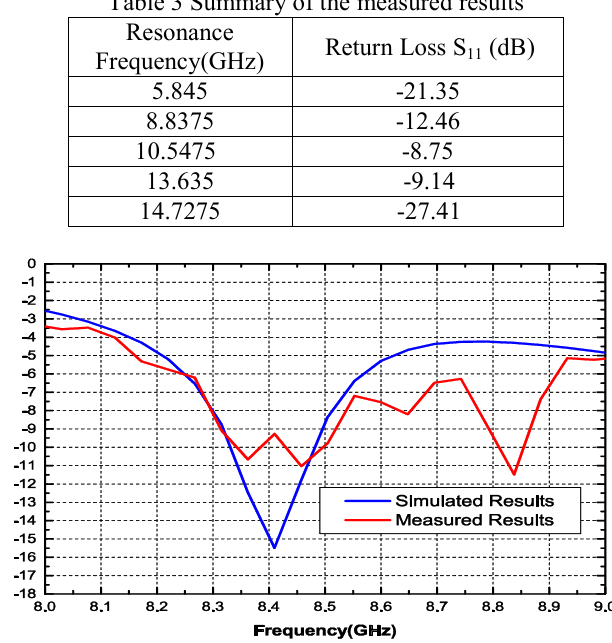
Figure 15: simulated and measured return loss at 8